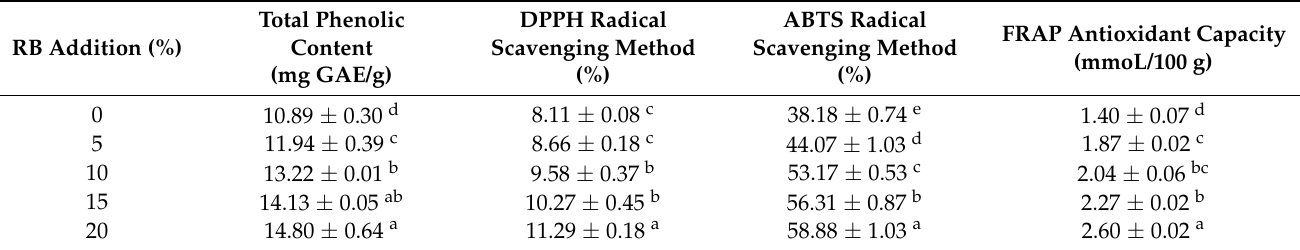
Table 1. The effect of RB content on the total phenolic content and antioxidant capacity of RB-SPI plant-based simulated